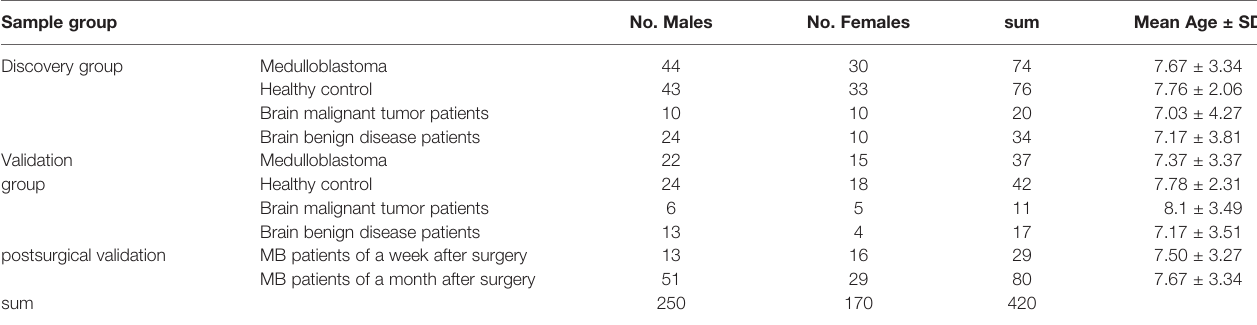
TABLE 1 | Demographics of medulloblastoma patients, brain benign disease patients, other brain malignant tumour patients and healthy controls. Sample